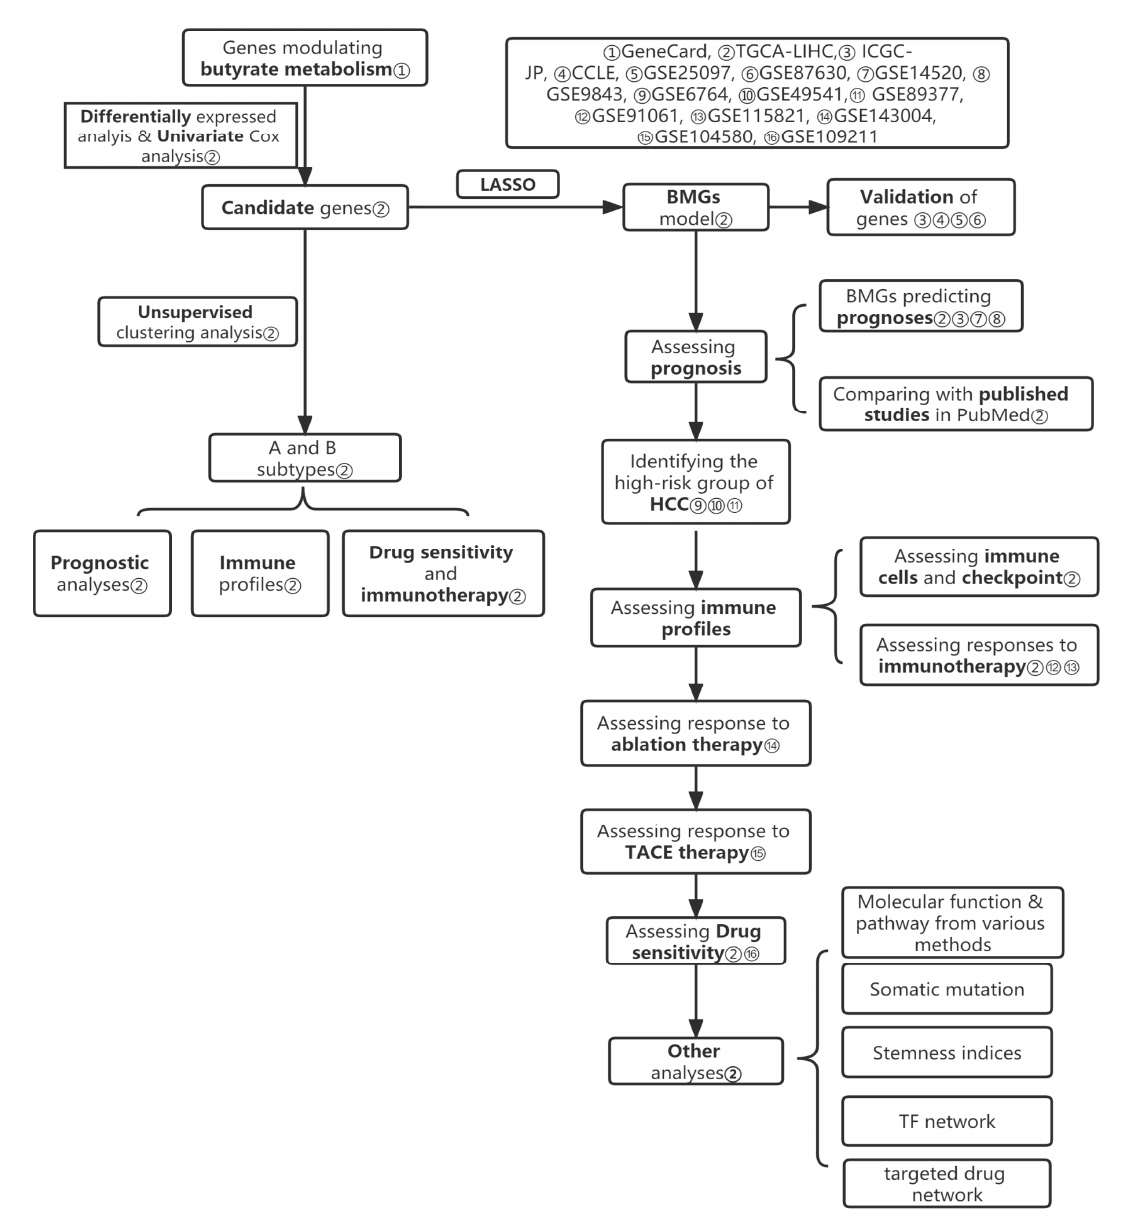
Figure 1. The flowchart of our study.